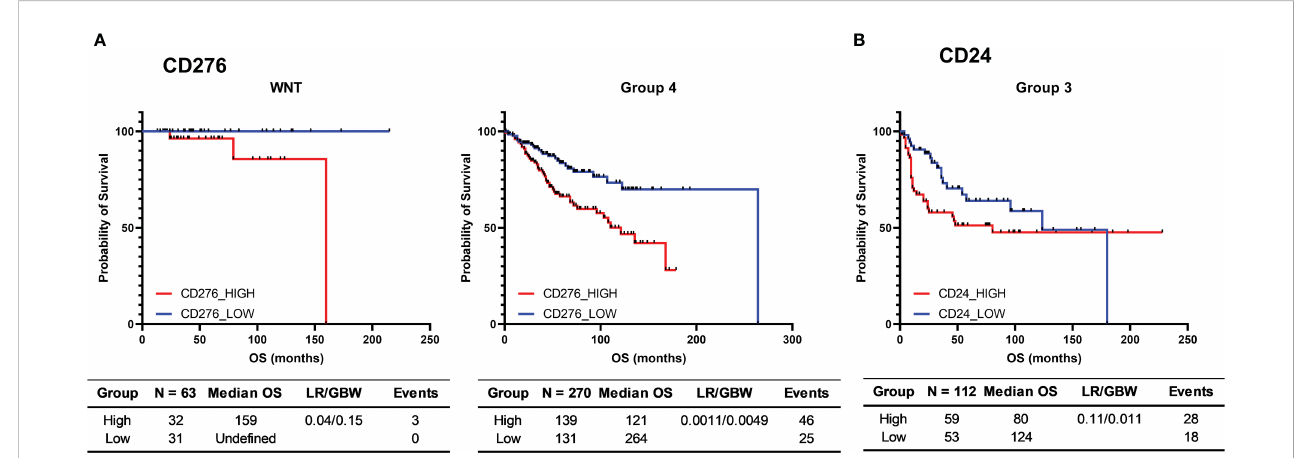
FIGURE 8 Kaplan-Meier curves for the survival of medulloblastoma patients from the 763 medulloblastomas Cavalli et al. cohort. (A) Probability of survival of CD276 low and high WNT and Group 4 medulloblastoma patients; (B) Probability of survival of CD24 low and high Group 3 medulloblastoma patients. High and low groups were established using the median as the cutoff point. The tables report the number of cases (N), median overall survival (Median OS), p- value obtained through the Log-rank test (p-value), hazard ratio and its associated 95% con fi dence interval, and the number of deaths (Events). Survival time is presented in